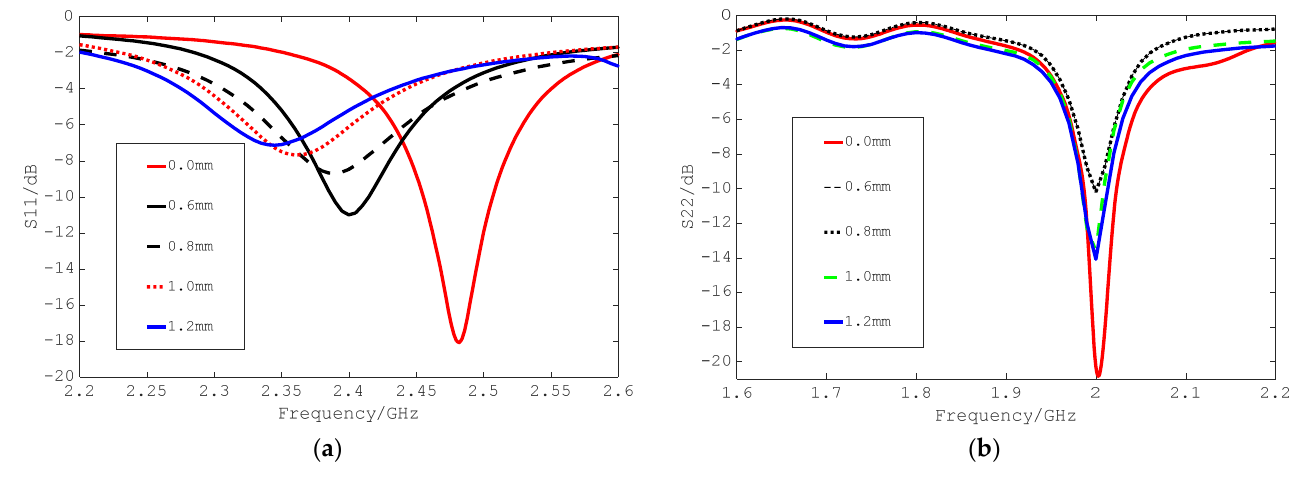
Figure 15. Measured reflection coefficient results of fabricated sensor for horizontal crack with different widths. ( a ) Port 1. ( b ) Port 2.